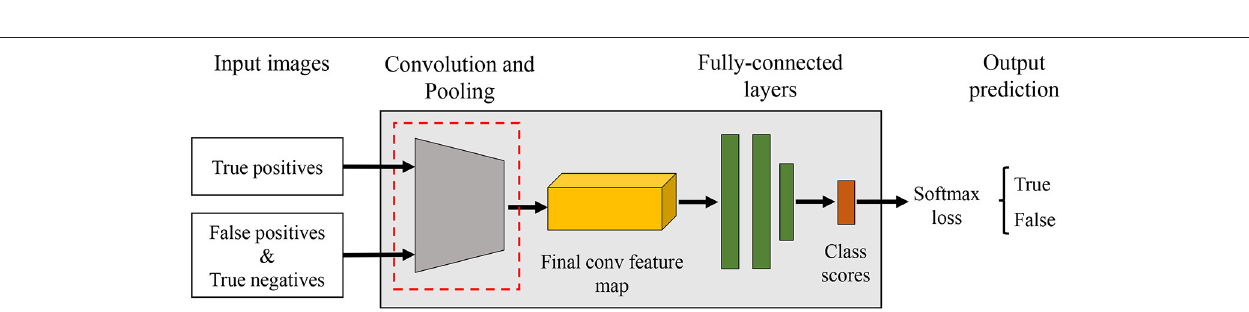
FIGURE 10 | Example of a CNN architecture used in the filter bank. The goal of each CNN is to verify if an input bounding box is likely containing the target category or not, as well as, to make the system more robust against intra- and inter-class